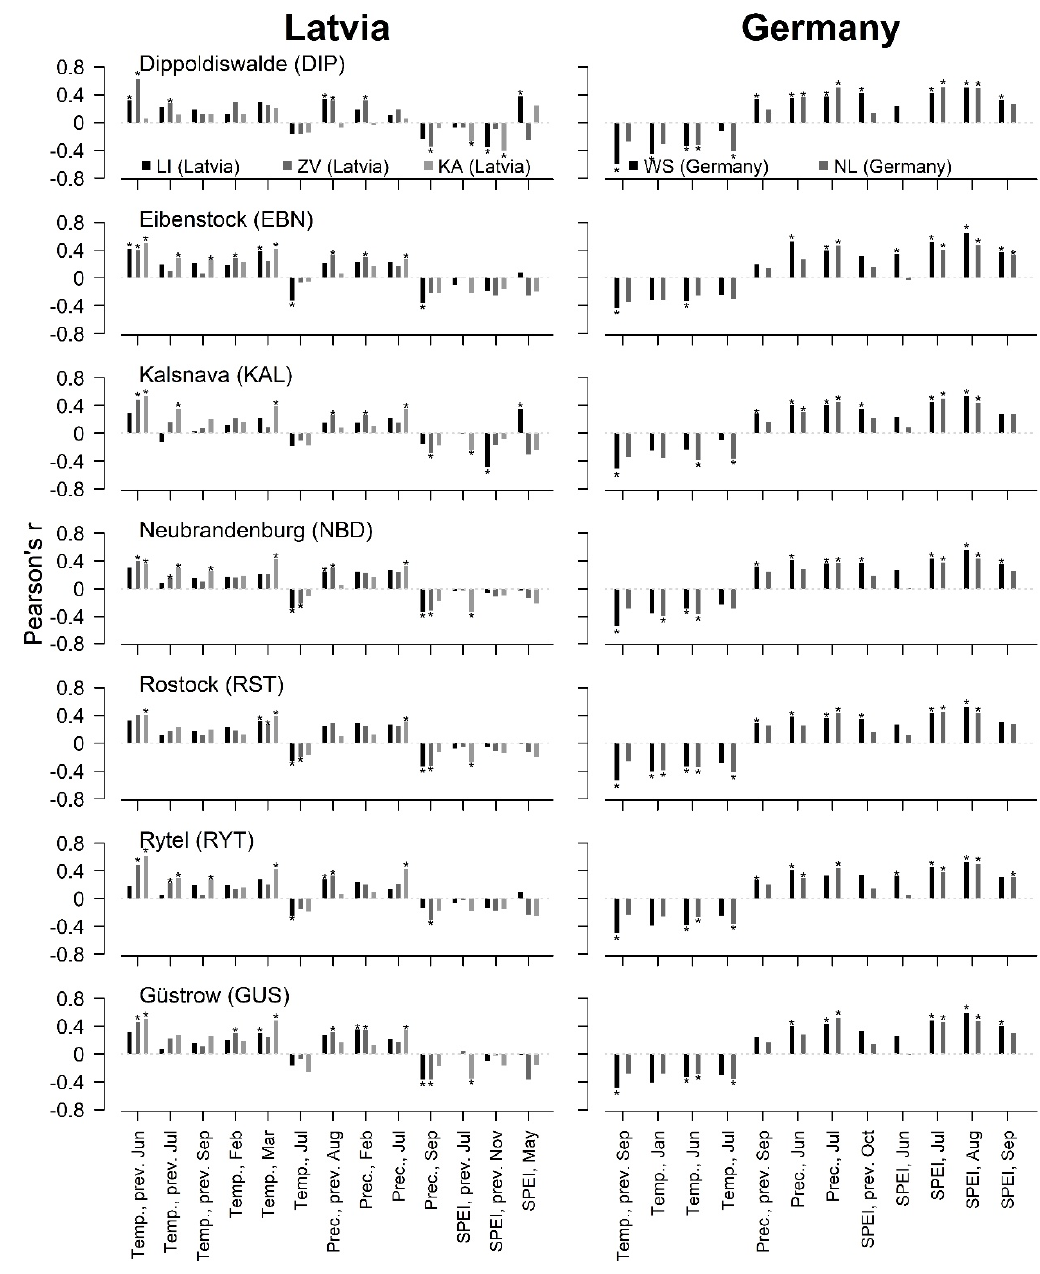
Figure 2. Bootstrapped Pearson correlation coefficients between the chronologies (prewhitened time series of the biweight robust mean) of basal area increment of the studied provenances of Scots pine and individual meteorological variables for the period 1985–2017 by trials (local weather data tested). The tested meteorological variables are monthly mean temperature (Temp.), precipitation sums (Prec.) and standardized precipitation evapotranspiration indices (SPEI). Asterisks (*) indicate significant correlations at α = 0.05. Note that a separate legend is given for each column of the panels (Latvia and Germany). Prev.—previous year.